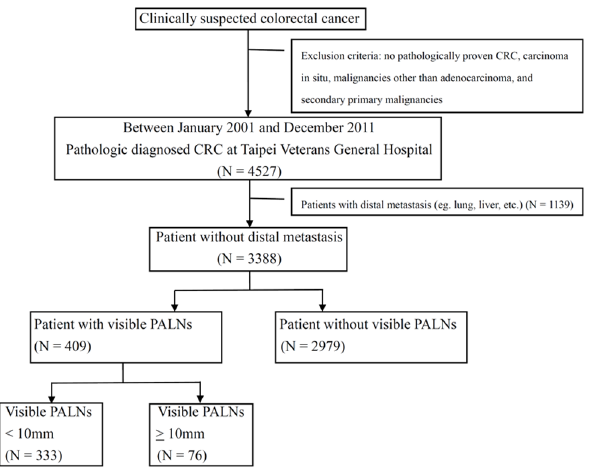
Fig 1. Flow chart of patient enrollment and exclusion. There were 4527 newly diagnosed CRC patients in our institution, including 1139 stage IV CRC with distal metastases. Only 3388 patients without distal metastases were selected and divided into the groups with or without visible PALNs. Four hundred and nine patients were identified as having visible PALNs without distal metastases.